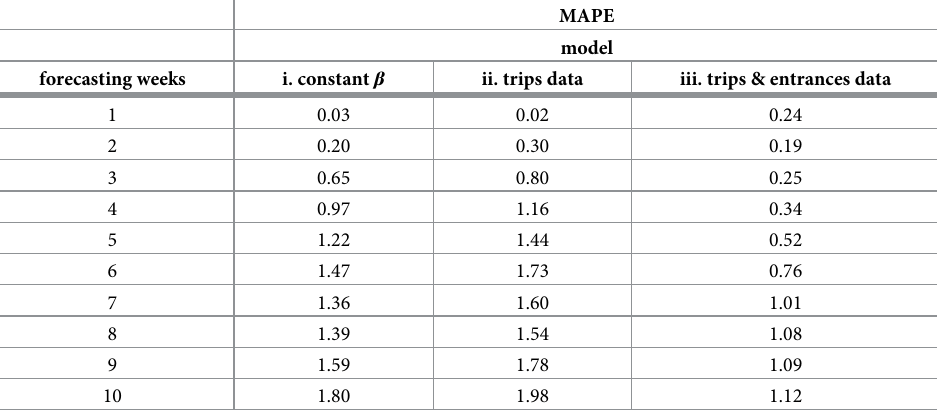
Table 1. MAPE results for the 3